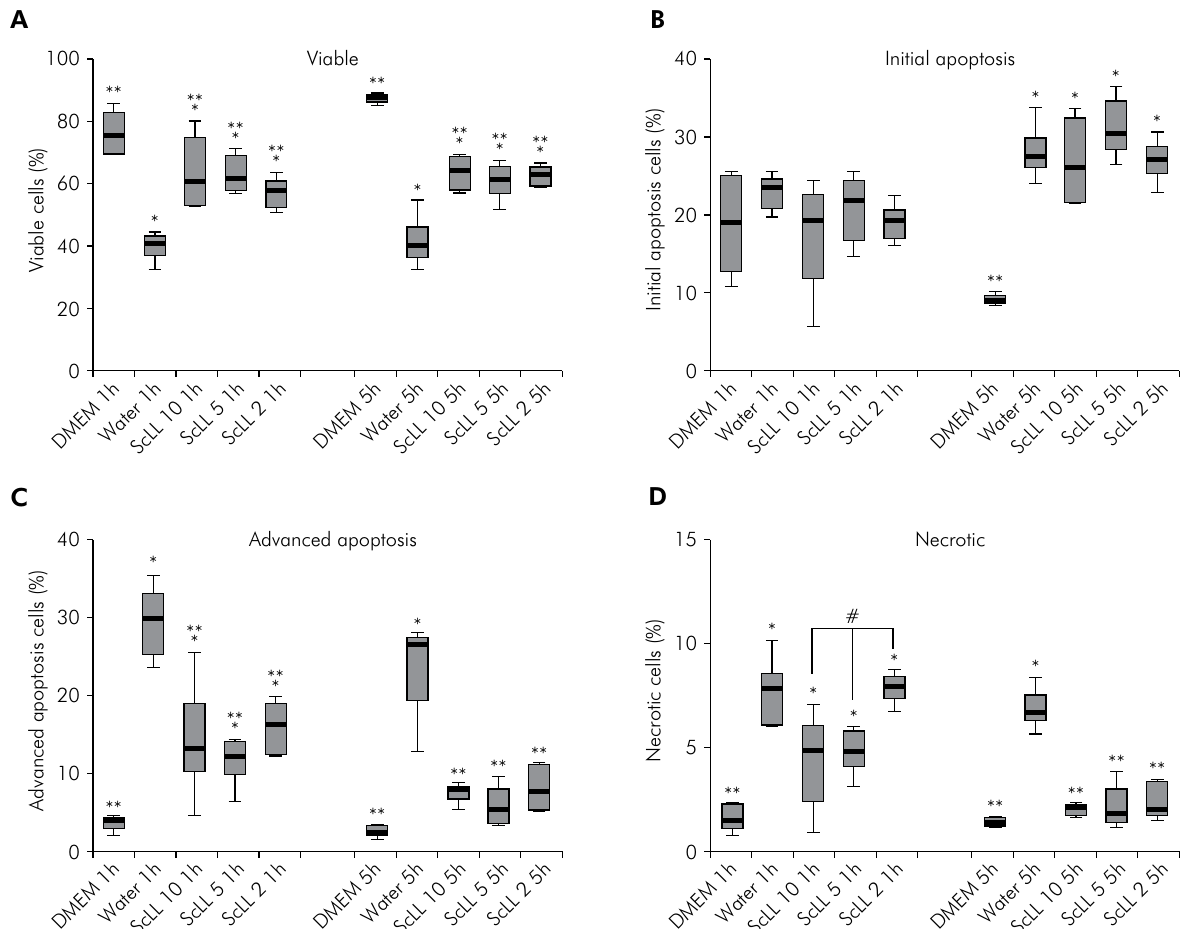
Figure 2. Results of flow cytometry analyses of the percentage of viable cells at 1 and 5 h (A); initial apoptosis cells at 1 and 5 h (B); advanced apoptosis cells at 1 and 5 h (C); necrotic cells at 1 and 5 h (D). Statistical significance was determined using one-way ANOVA and Dunnet’s test. #p<0.05 compared between the experimental groups. *p < 0.05 compared with positive control (DMEM). **p < 0.05 compared with negative control (tap